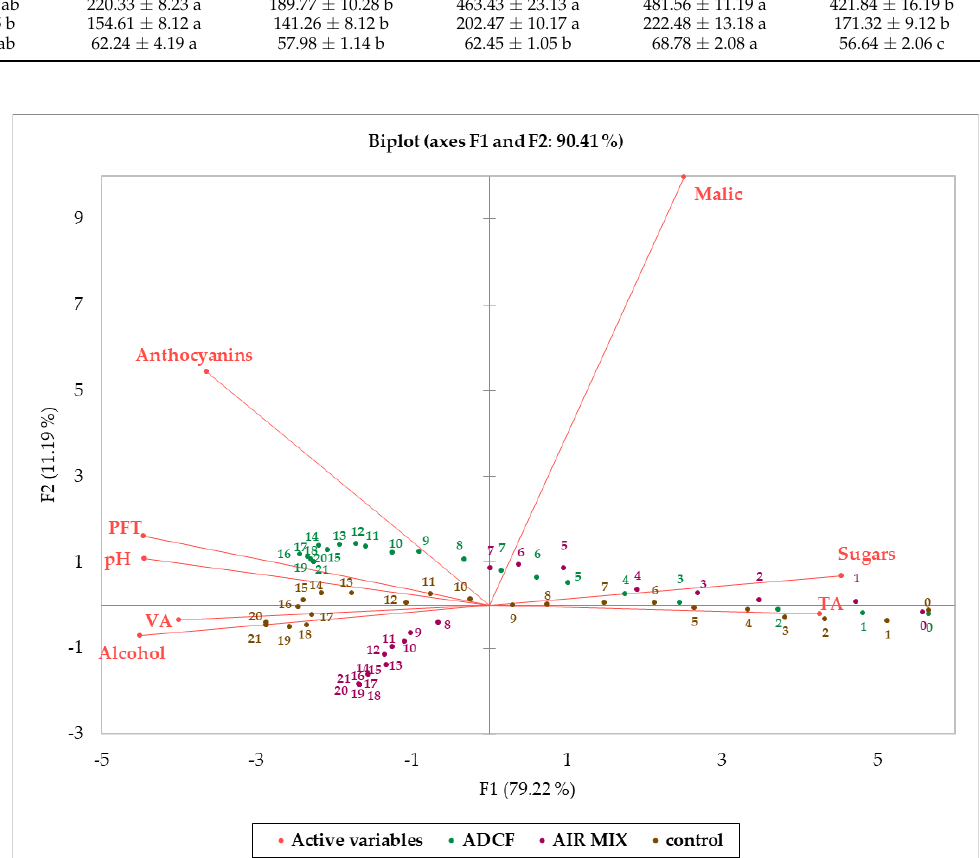
Figure 3. Principal component analysis (PCA) biplot of the fermentation process using the three different maceration techniques (average of the data of 2020 and 2021 year). TA, titratable acidity; VA, volatile acidity; PFT, total polyphenols. The numbers indicate the days of fermentation/maceration.